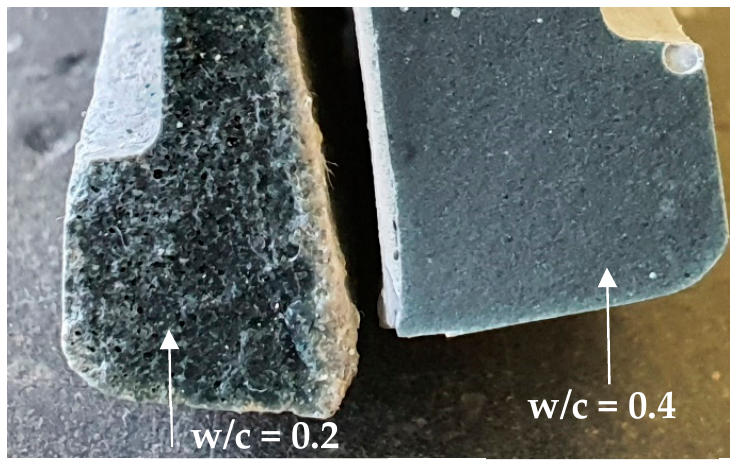
Figure 6. Cross-section of a cement paste with w/c = 0.2 ( left ) and a cement paste with w/c = 0.4 ( right ) at 28 days.